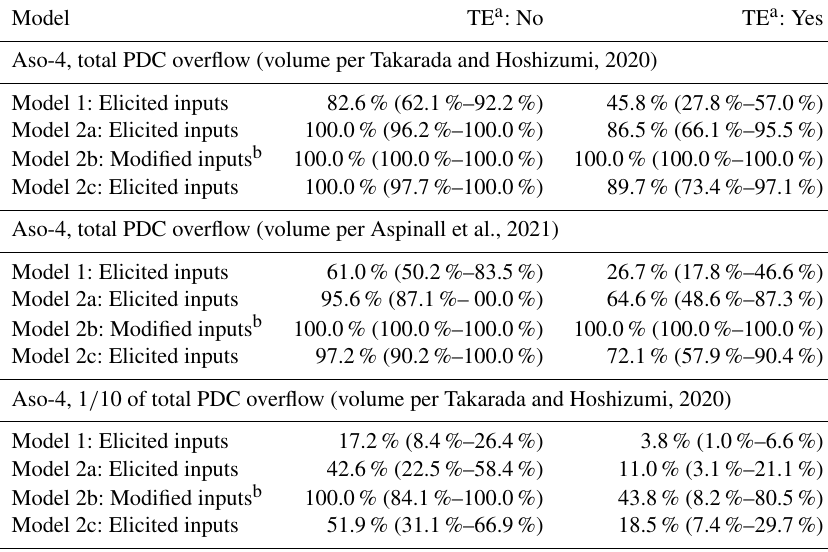
Table 3. Numerical results of the probability that a PDC derived from a caldera-forming eruption similar to Aso-4 reaches MS1, with and without topographic effects. For each scenario, we present the values of the cumulative curves displayed in Fig. 4 at the central point of the variation range of the PDC mass, while between parentheses we include the results at the extremes of these variation ranges. We test the mass of PDC overflow outside of the caldera of Aso-4 and 1 / 10 of that estimate, tentatively representing the Aso-4T unit.